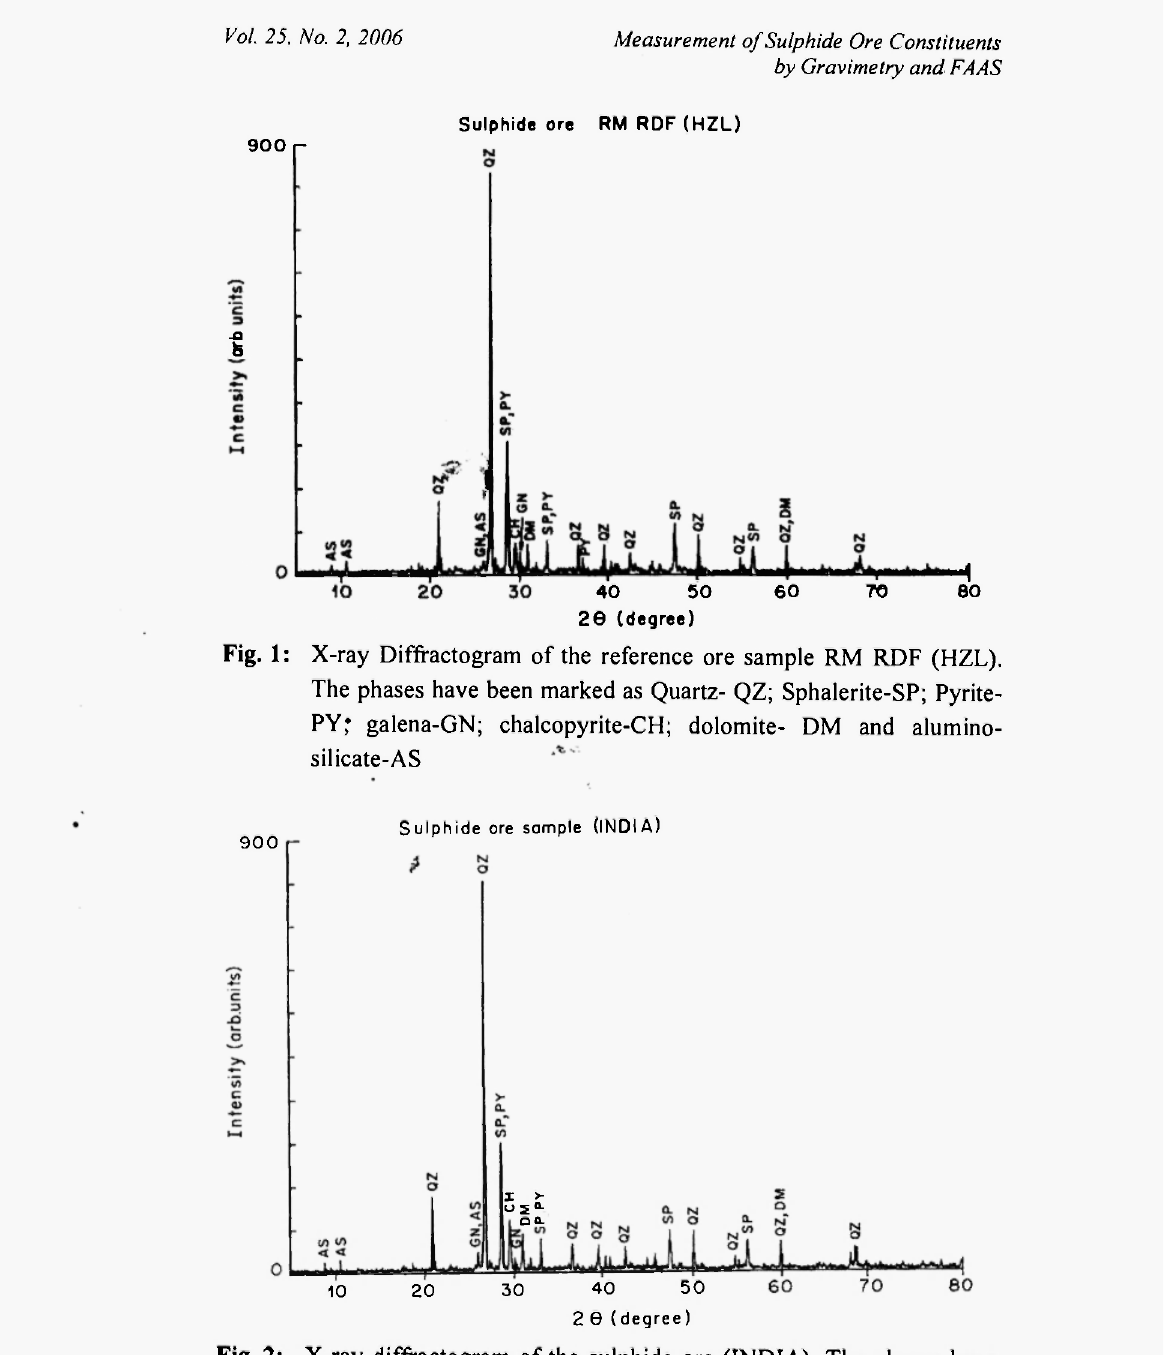
Fig. 2: X-ray diffractogram of the sulphide ore (INDIA). The phases have been marked as Quartz- QZ; Sphalerite-SP; Pyrite-PY; galena-GN; chalcopyrite-CH; dolomite- DM and alumino- silicate-AS